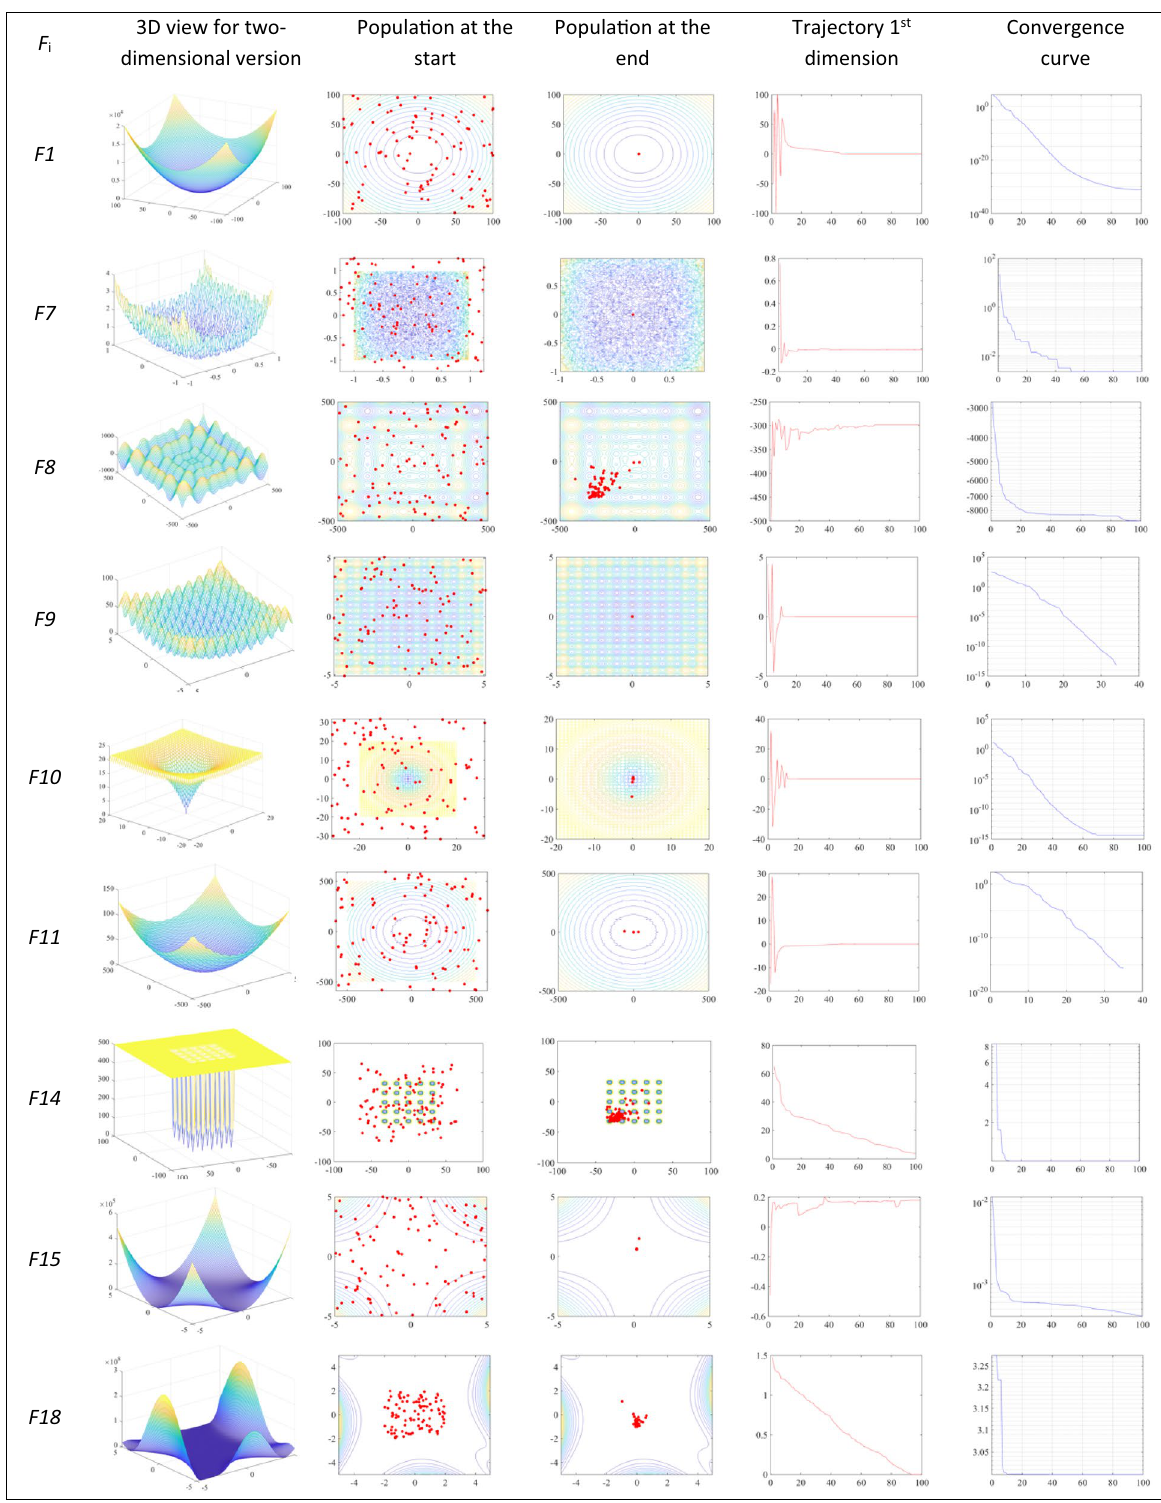
Figure 6. Level of convergence of POA after 100